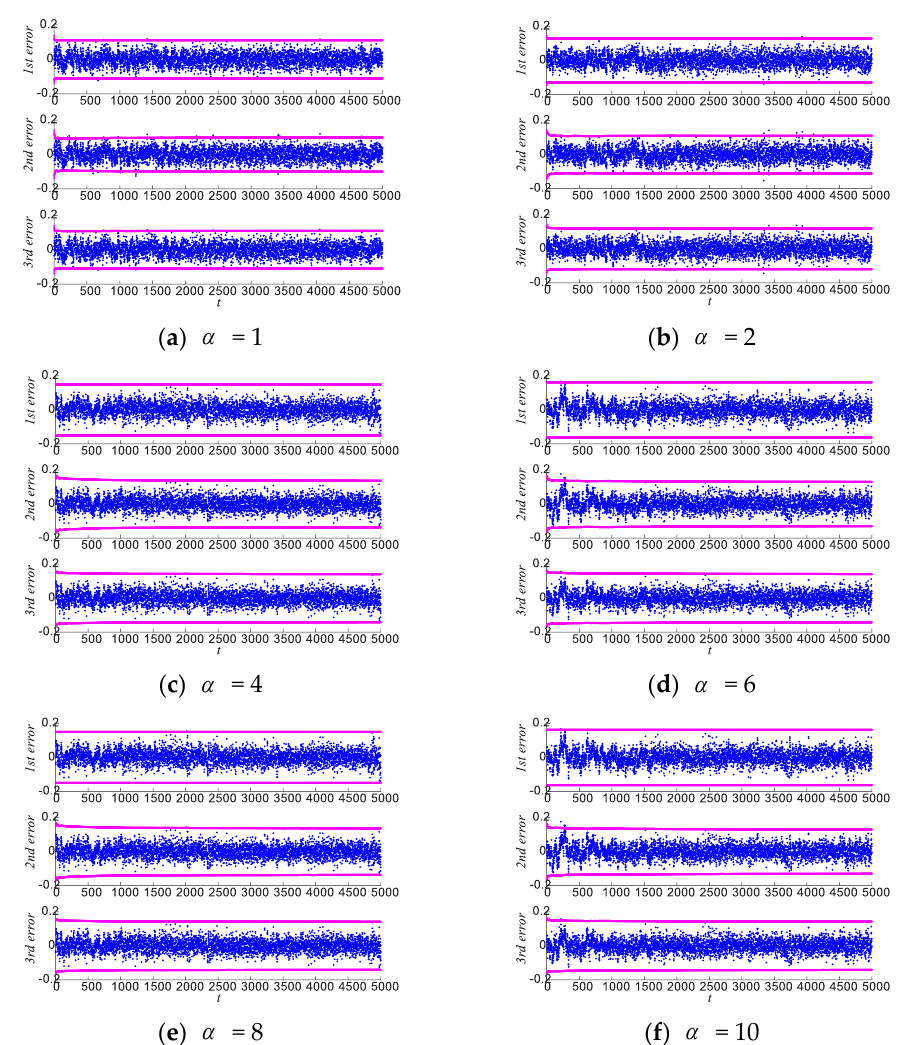
Figure 7. The 10.